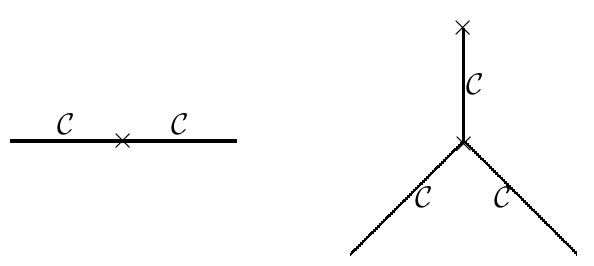
Figure 2 . This diagram represents two other contributions, besides the one shown in (cid:12)gure 1, to the disk two point function of a pair of closed strings. The (cid:12)rst diagram represents the two point closed string interaction vertex described by a disk amplitude with two closed strings, and the second diagram represents a Feynman diagram that joins the closed string three point vertex to a closed string one point vertex by a closed string propagator. Since in our analysis the second diagram will not give a divergent contribution, we shall include its contribution in the de(cid:12)nition of the interaction vertex of two closed strings shown in the (cid:12)rst